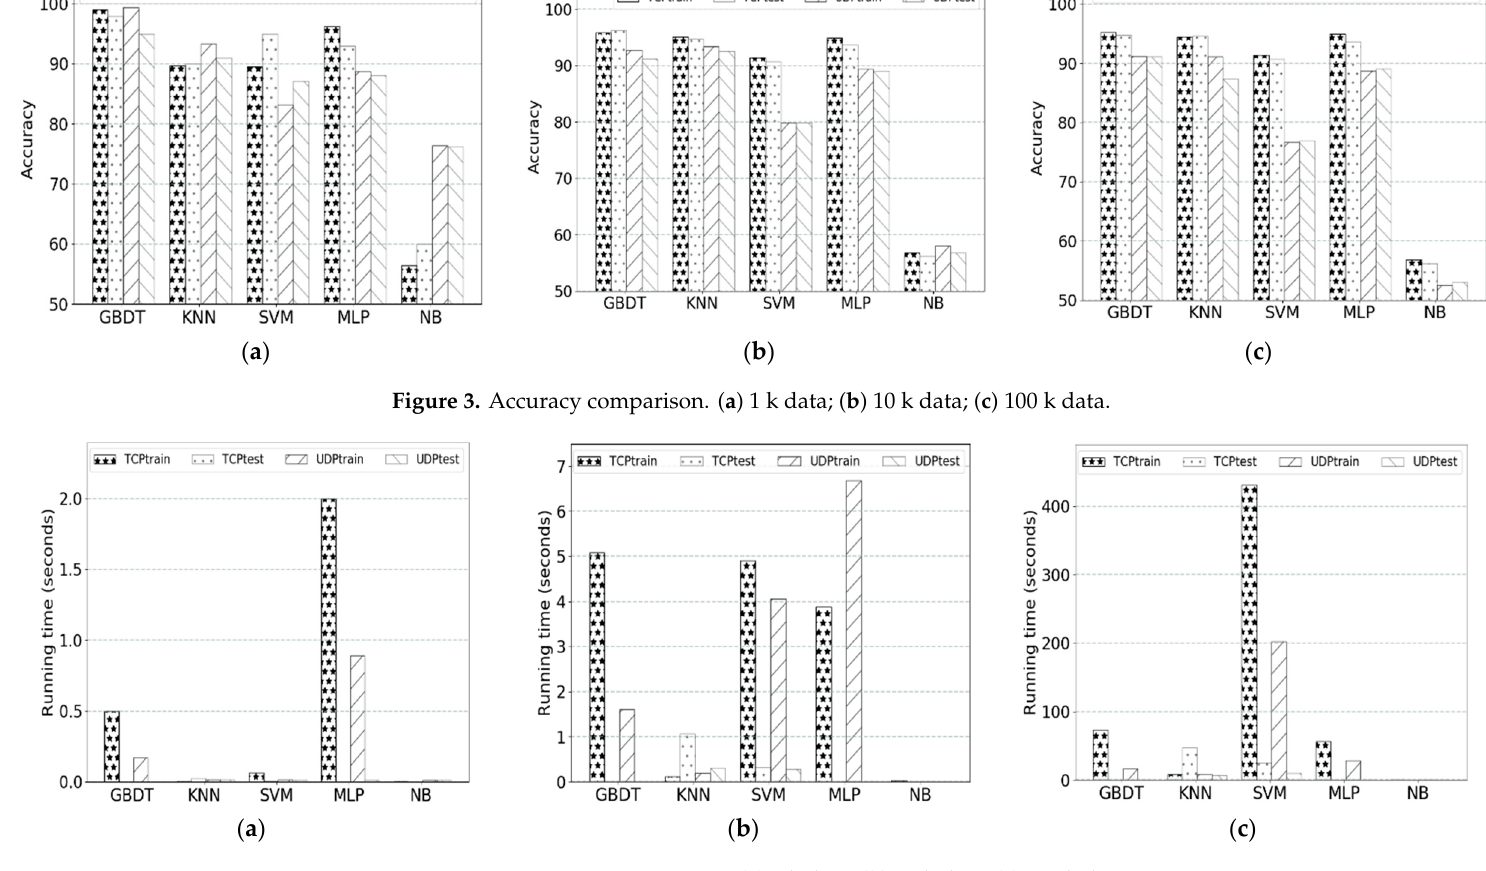
Figure 4. Running time comparison. ( a ) 1 k data; ( b ) 10 k data; ( c ) 100 k data.